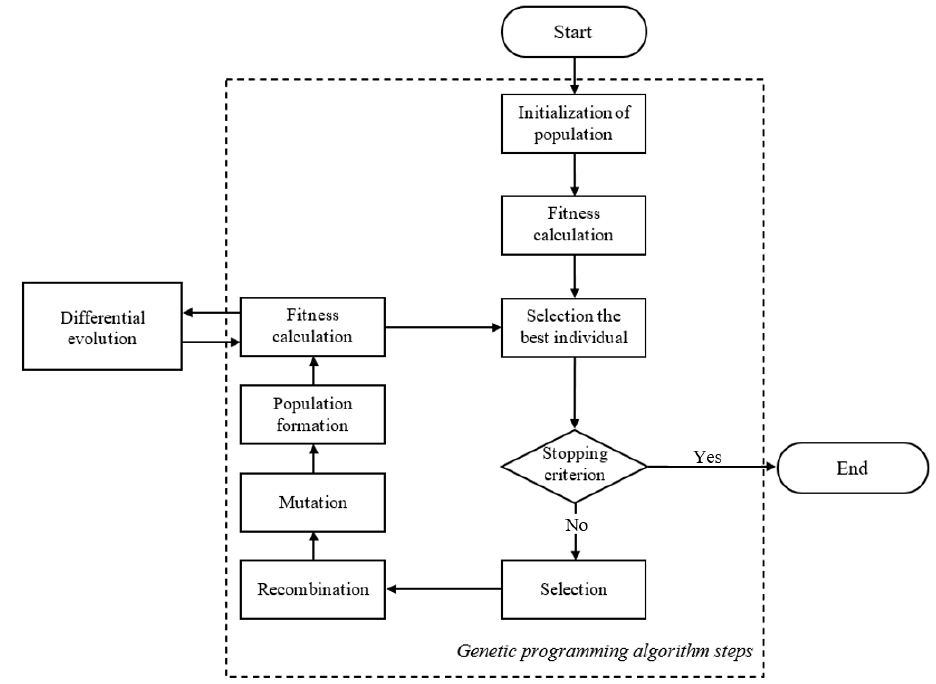
Figure 2. Scheme of the evolutionary approach EvolODE for the identification of dynamical systems in the form of ODE.